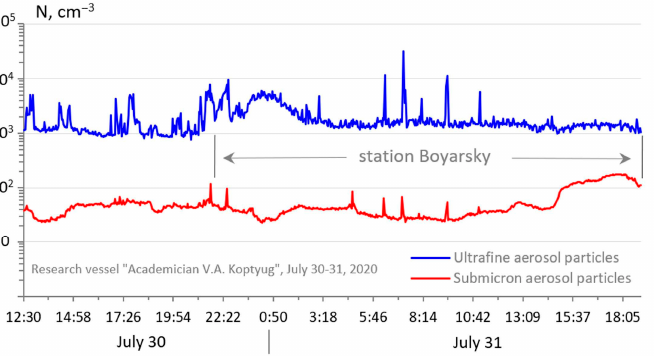
Figure 4. Temporal variation of the concentration of ultrafine atmospheric particles (upper curve) and submicron particles (lower curve) in the driving layer of Lake Baikal, 30–31 July 2020. Total concentrations of sulfate ions, nitrate ions, and ammonium cations in aerosol samples taken during the parking period near the station Boyarsk accounted for 88% of the total amount of